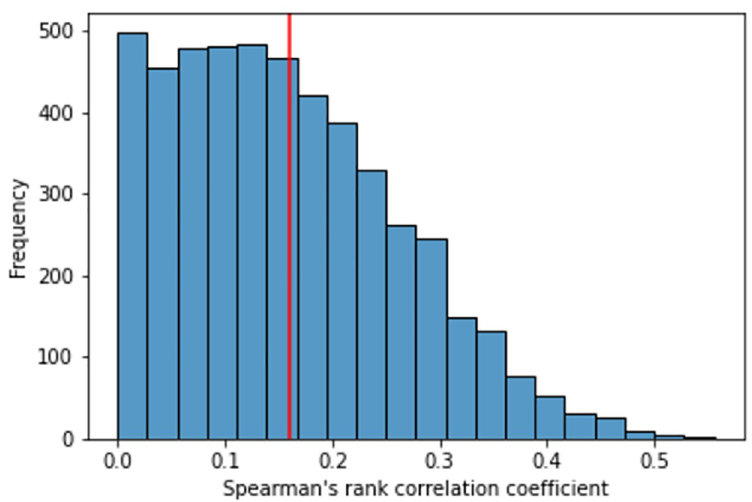
Fig 6. Histogram of frequency of Spearman correlation values between pairs of events considering M M BERT